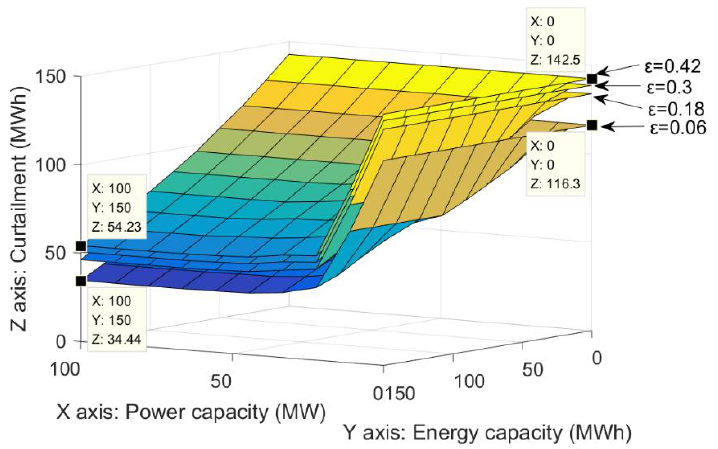
Figure 7. Comparison of optimal value functions with different values of 𝜀 .